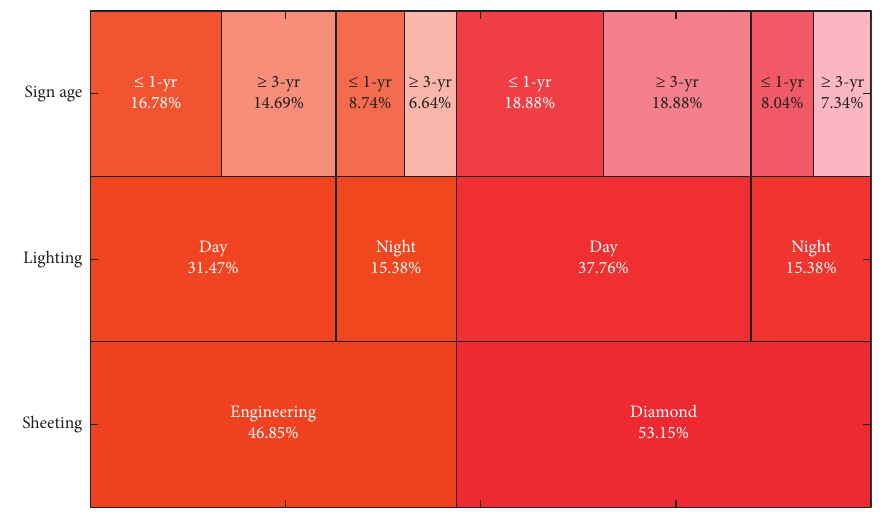
Figure 6: Share of samples according to sign age, sheeting type, and lighting